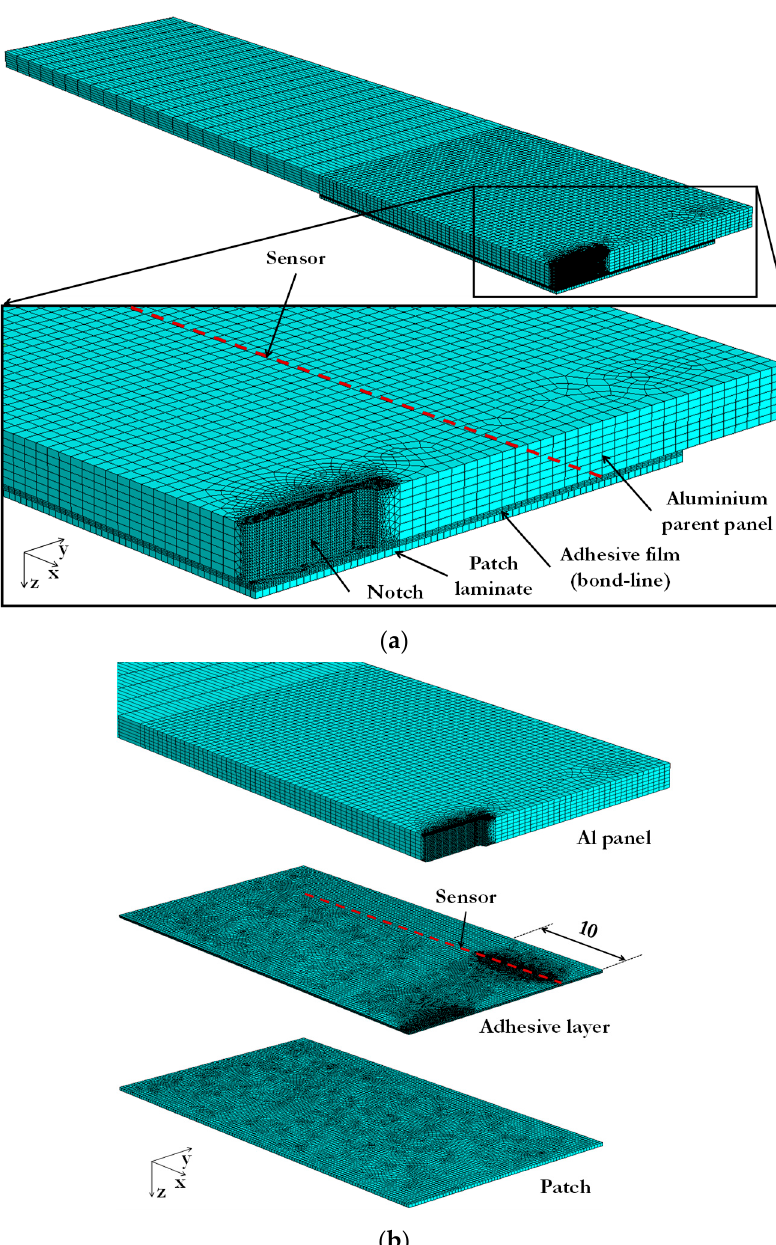
Figure 9. ( a ) General and detailed view of the FE mesh of the Al/GFRP patch repair model and ( b ) individual mesh of the aluminium parent panel, adhesive layer, and patch